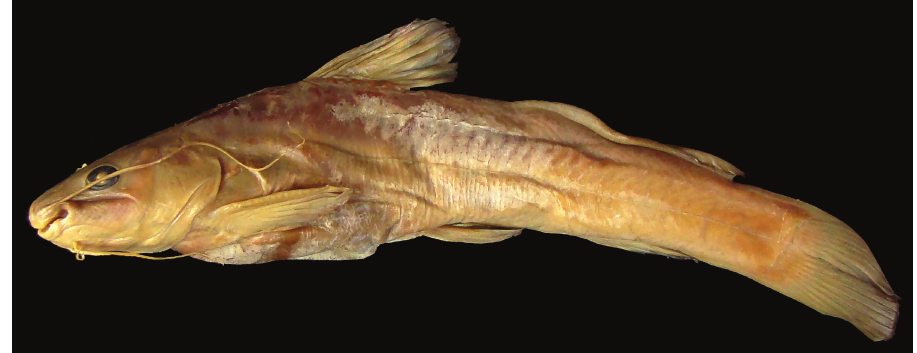
Fig. 3. Lateral view of paratype of Rhamdia branneri , FMNH 54237, 100.0 mm SL, Brazil, Paraná, Serrinha, rio